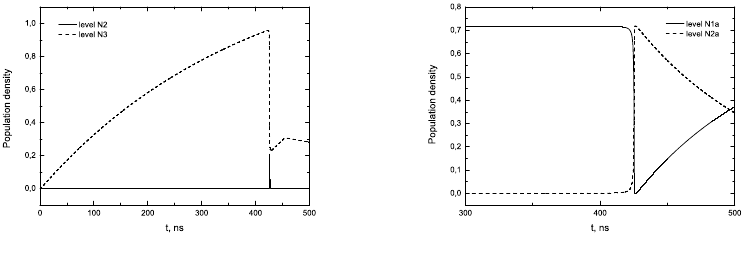
Figure 7. Temporal changes of population densities in AE and pQ-sw during the pumping and pulse generation. is smooth but very fast. Therefore, for generating smooth pulses by AQS its opening should be fast and smooth